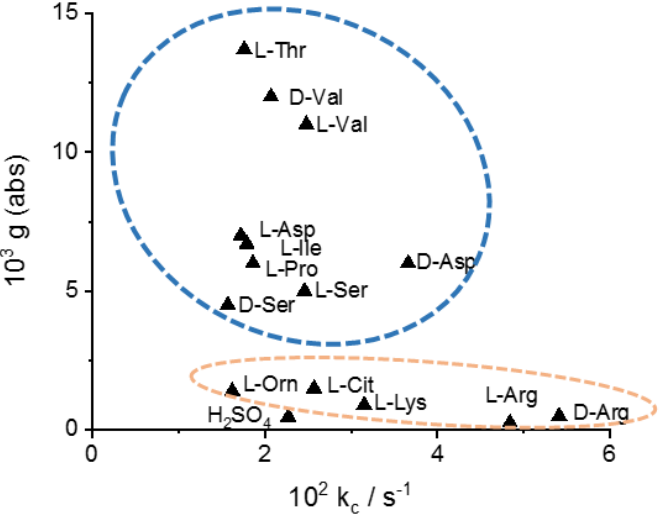
Figure 7. Plot of the absolute values for the dissymmetry g -factor measured at the J-band for J- aggregates of TPPS 4 in the presence of the various amino acids as function of the corresponding autocatalytic rate constant k c . The dashed lines gather amino acids with similar overall charge and/or kinetic